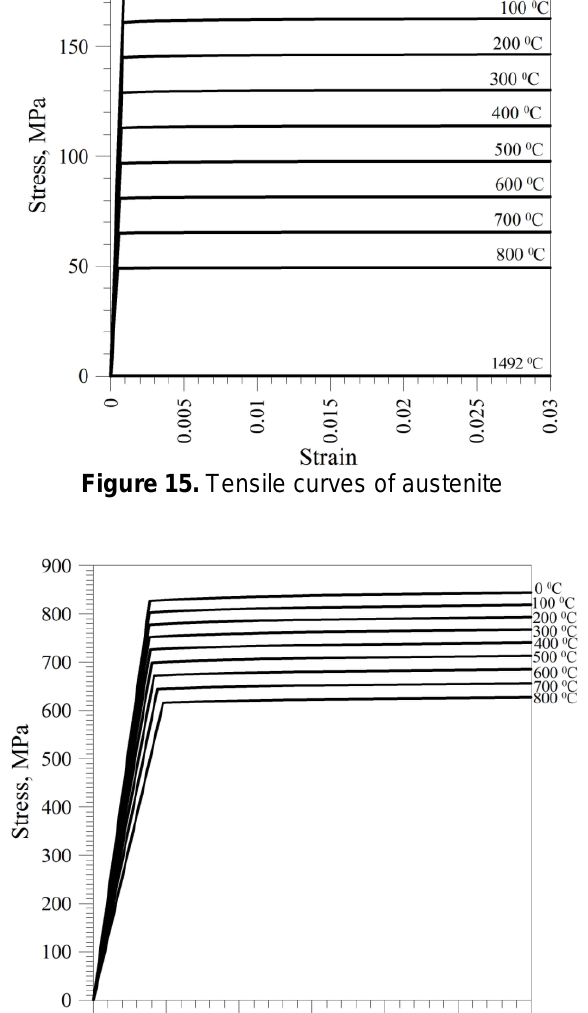
Figure 17. Tensile curves of ferrite